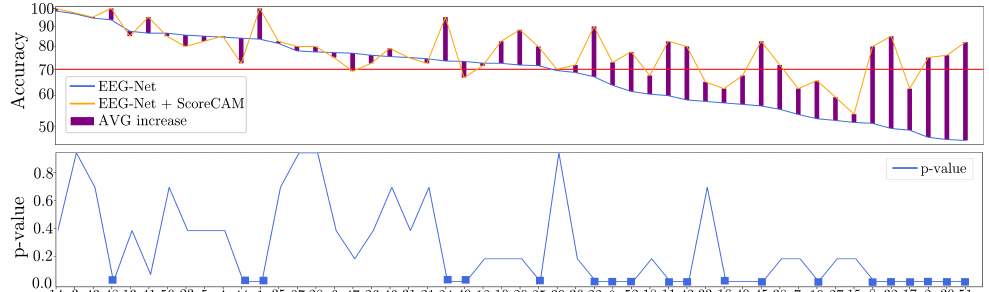
Figure 5. Subject-dependent MI discrimination results. ( Up ): Classification accuracy achieved for Bi-class MI tasks (left-hand and right-hand). Note: the red line at 70% level shows frequently used for fixing the poor MI coordination skill threshold under the subjects are considered as worse-performing. ( Bottom ): Obtained p -value per subject using the Nemenyi post-hoc test (square marker represents a p -value < 0.05).